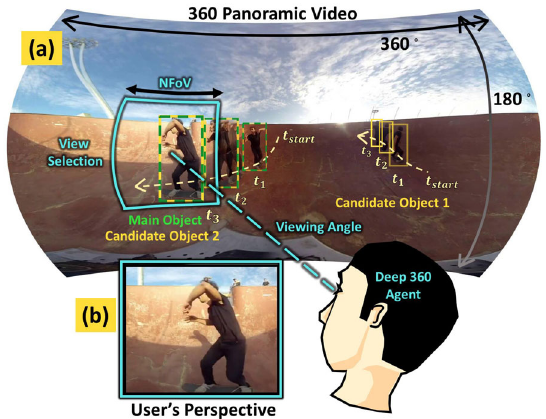
Fig. 12 Deep 360 Pilot for NFOV selection in 360 ◦ sports video. (a) Three overlapping panoramic frames sampled from a 360 ◦ skateboarding video with two skateboarders. The proposed “Deep 360 Pilot” selects a viewing angle, and NFOV center. (b) NFOV from a viewer’s perspective. Reproduced with permission from Ref. [153], c (cid:2) Institute of Electrical and Electronics Engineers